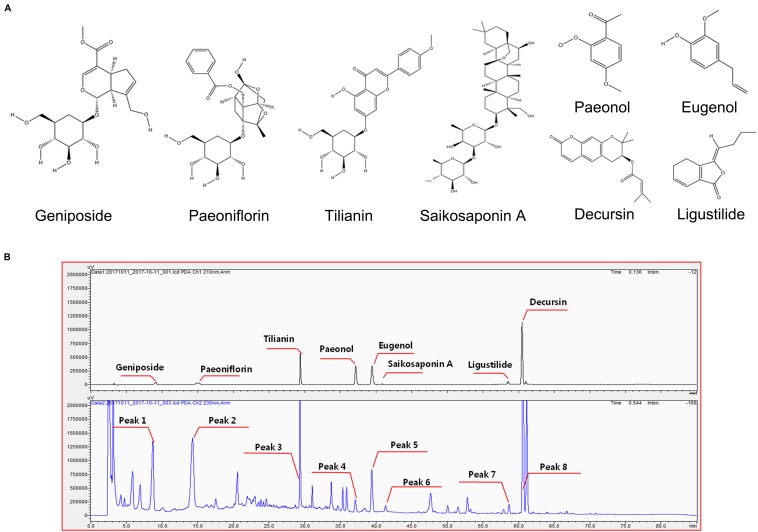
Chemical structure of reference compounds and HPLC chromatograms of GCF samples. (A) Chemical structures of the reference compounds were drawn using ChemDraw software. (B) Eight reference compounds were selected, and their retention times observed using the Shimadzu PDA system (upper panel). Eight peaks with same retention time were identified from GCF extracts (lower panel).